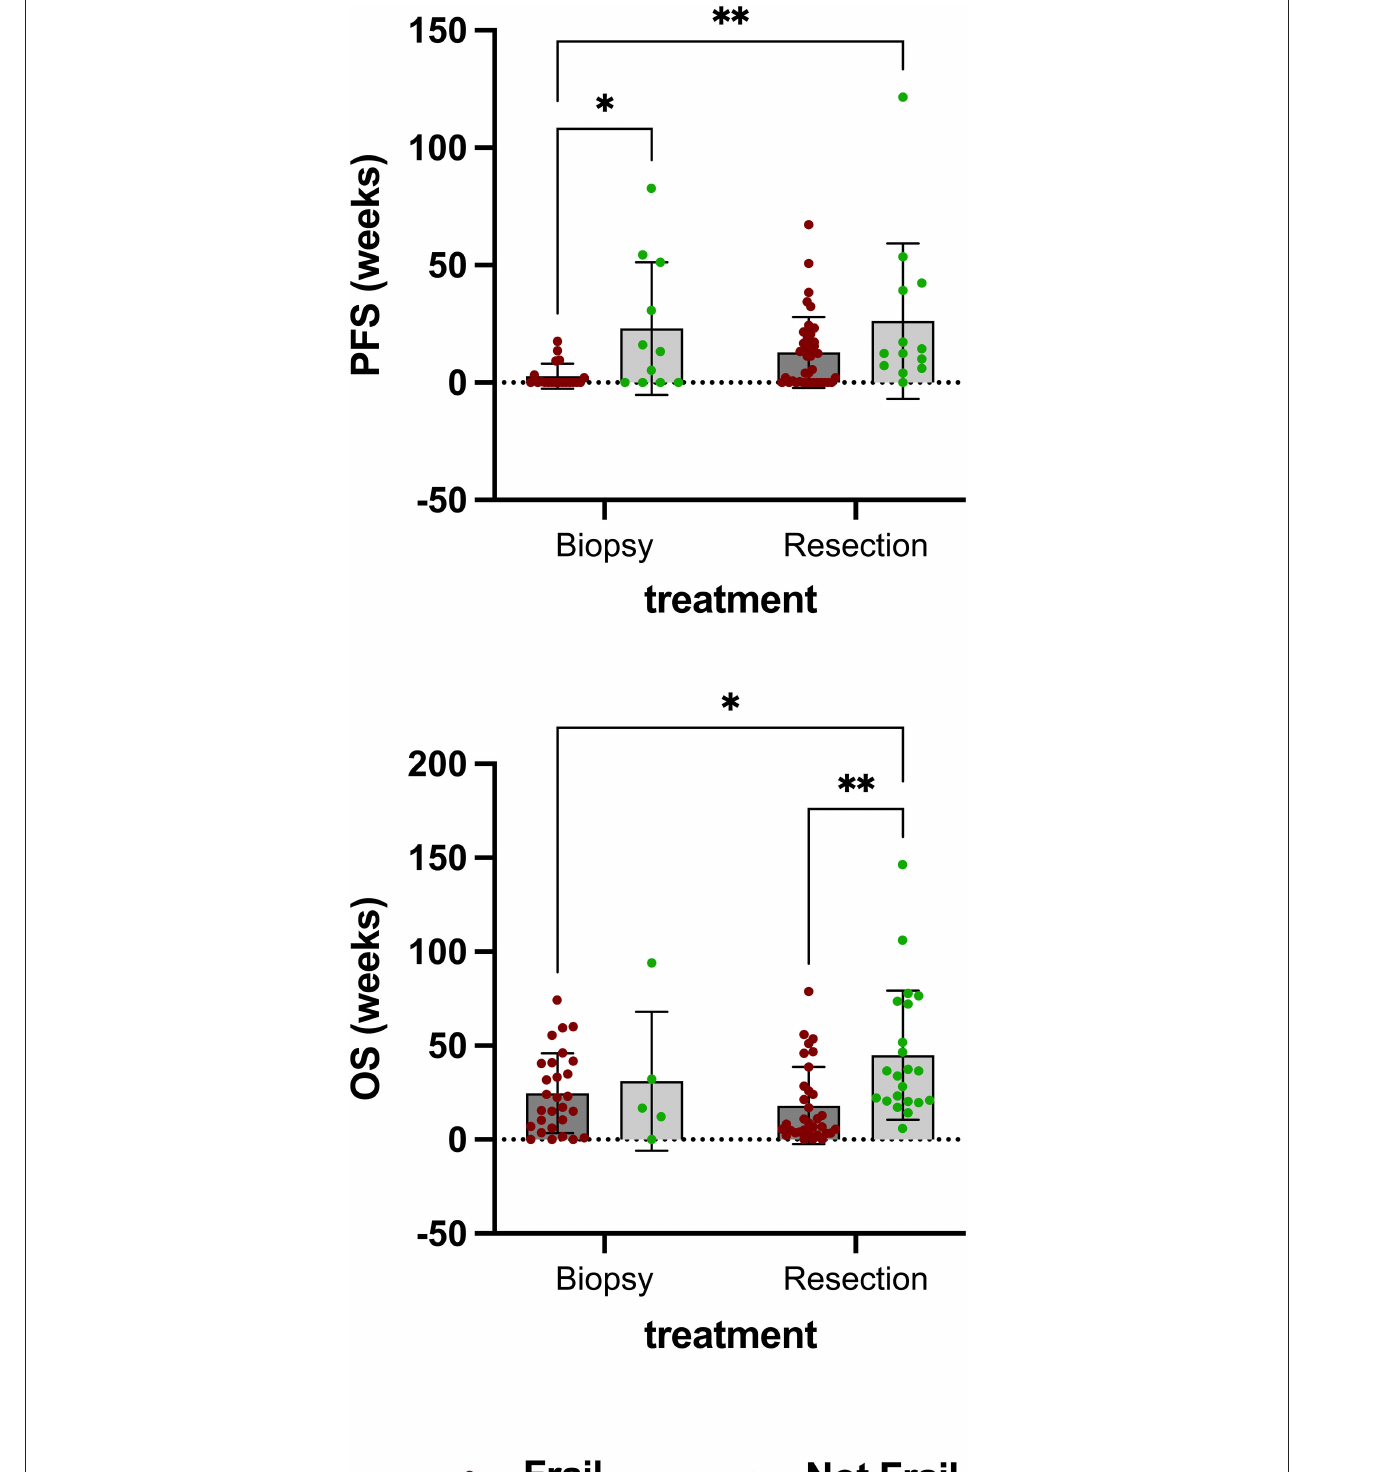
FIGURE 4 | There was no statistically significant difference in the number (cases) of resections performed in patients stratified as not frail (75.00%) and in those defined as frail (58.73%). While tumor resection led to improved PFS in patients defined as frail compared to biopsy alone ( p = 0.0069), it was only associated with improved overall survival in patients defined as not frail ( p =